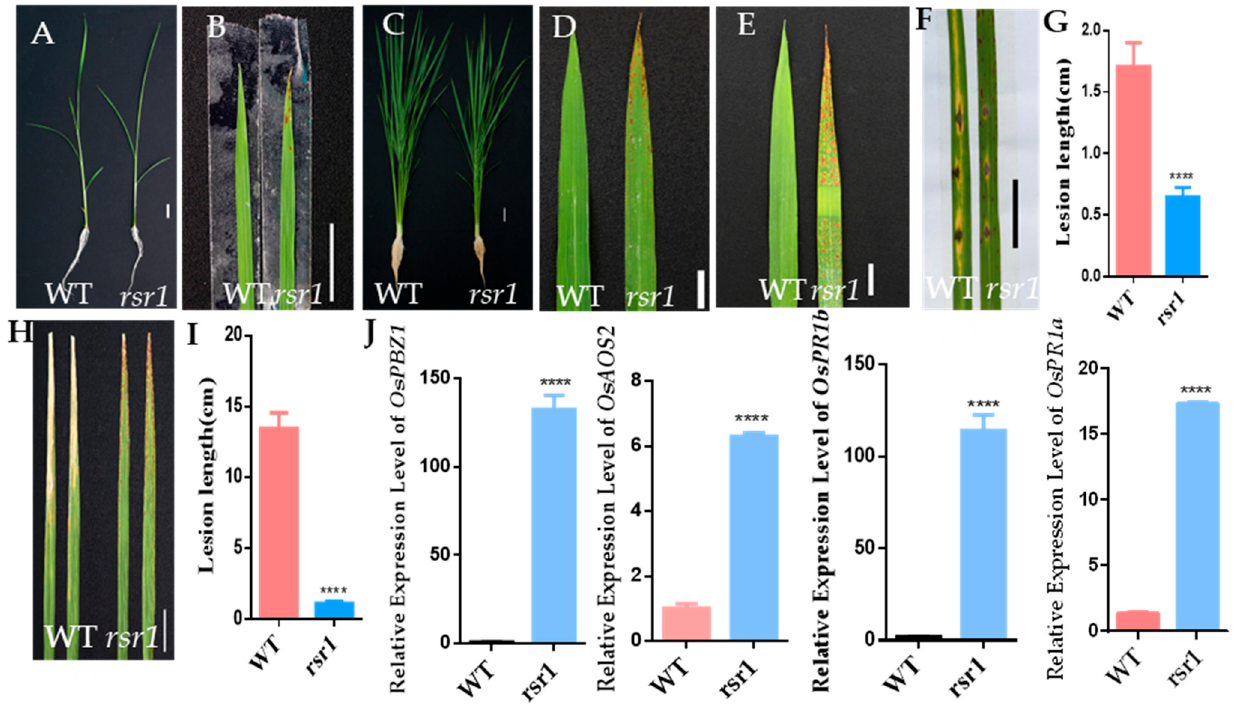
Figure 1. Phenotypic characterization of the rsr1 mutant. ( A ) Wild-type (WT) and rsr1 mutant plants at the seedling stage. Bar = 2 cm. ( B ) Leaves of WT and rsr1 mutant plants at the seedling stage. Bar = 2 cm. ( C ) Wild-type (WT) and rsr1 mutant plants at the heading stage. Bar = 2 cm. ( D ) Leaves of WT and rsr1 mutant plants at the heading stage. ( E ) The phenotype of rsr1 mutant leaf blades after shading with foil for 7 days. ( F ) Punch inoculation of rsr1 mutant and WT plants with the compatible M. Oryzae isolate RB22. Leaves were photographed at 7 dpi. Scale Bar = 2 cm. ( G ) Lesion area of the inoculated leaves of rsr1 mutant and WT plants at 7 dpi. Error bars represent + SD ( n = 12). ( H ) Leaves of rsr1 mutant and WT plants were inoculated with compatible Xoo isolate P6. Leaves were photographed at 7 dpi. Scale Bar = 2 cm. ( I ) Lesion length on the leaves of rsr1 mutant and